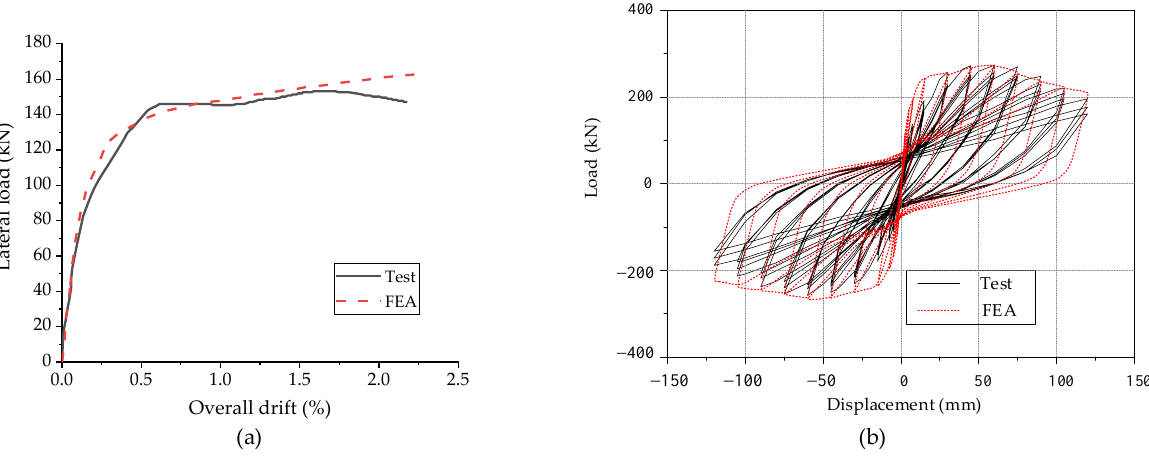
Figure 6. Load-displacement curve: ( a ) shear wall specimen RW2; ( b ) frame specimen PCF − 1.